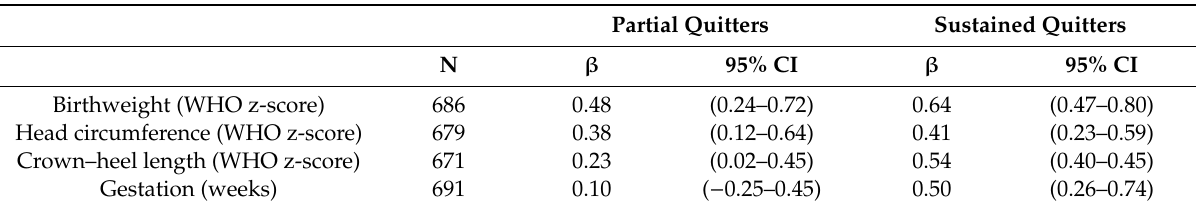
Table 4. Infant characteristics (adjusted *) according to maternal smoking status compared with sustained smokers as